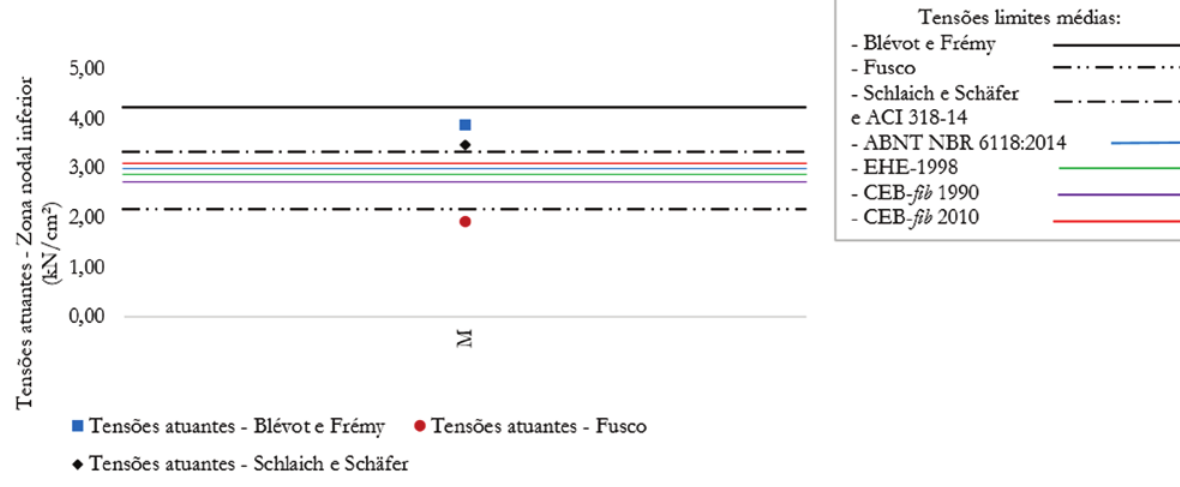
Modelos ensaiados por Mesquita [12] × σ